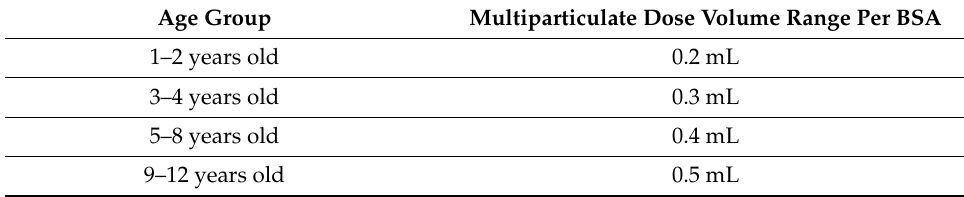
Table 2. Dosage Volume by Age.